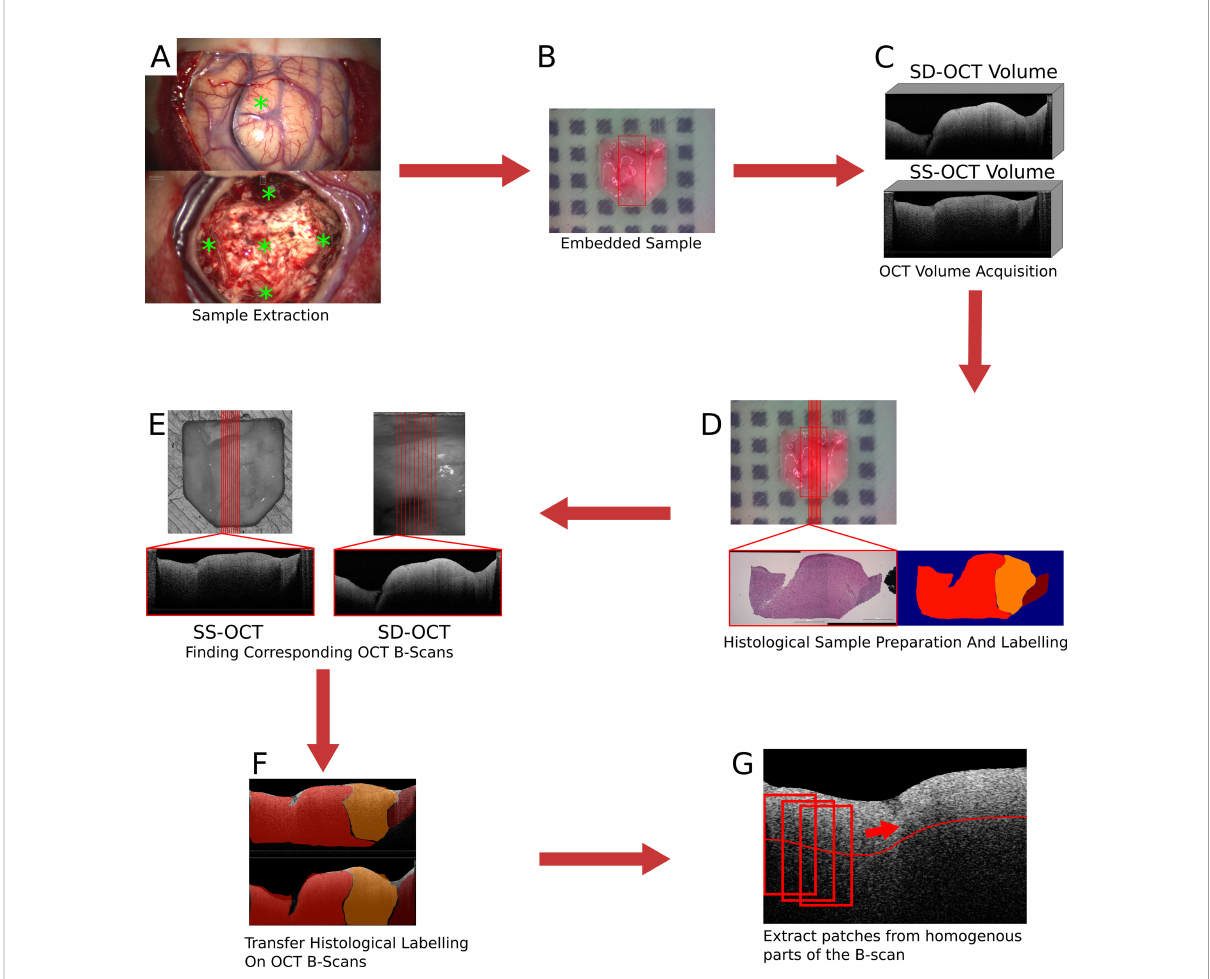
FIGURE 1 Images of the brain surface and the resection cavity (A) . * marks the locations where samples were extracted. Embedded sample in agarose- fi lled tissue cassette (B) . In (B) , the red square marks the fi eld of view of the SD-OCT system. Examples of acquired OCT volumes by the two OCT systems (C) . An example of the H&E stained histological cut and the label set by the neuropathologist (D) . In (D) , the location of the histological section was marked by the red line. Extracting the corresponding OCT B-scans from the OCT volumes based on the position of the transformed cutting line (E) . An example of the transferred label on the corresponding OCT B-scans (F) . Extraction of patches from homogeneous parts of the B-scan (G)